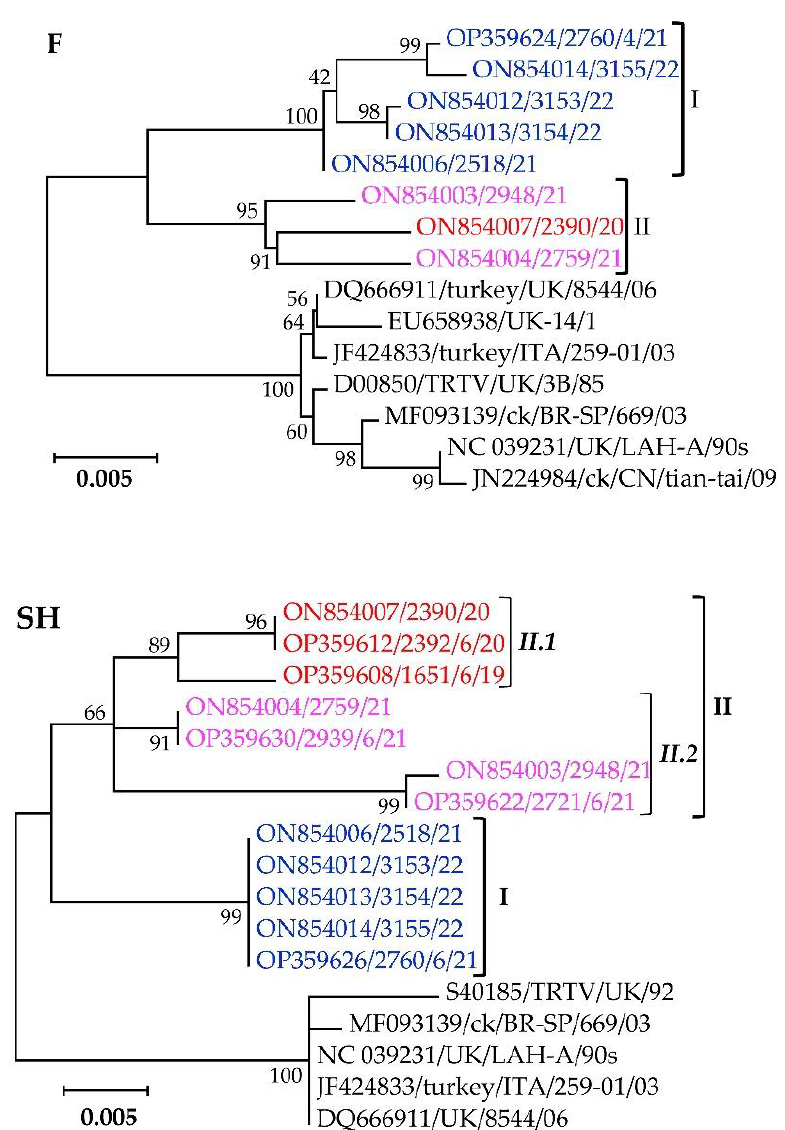
Figure 5. Phylogenetic analysis of the fusion (F) and small hydrophobic (SH) glycoproteins of the Mexican aMPV-A isolates (highlighted in color) identified in this study and other previously reported aMPV-A strains. Isolate/strain names include GenBank accession number, avian species, country, and year of sample collection.